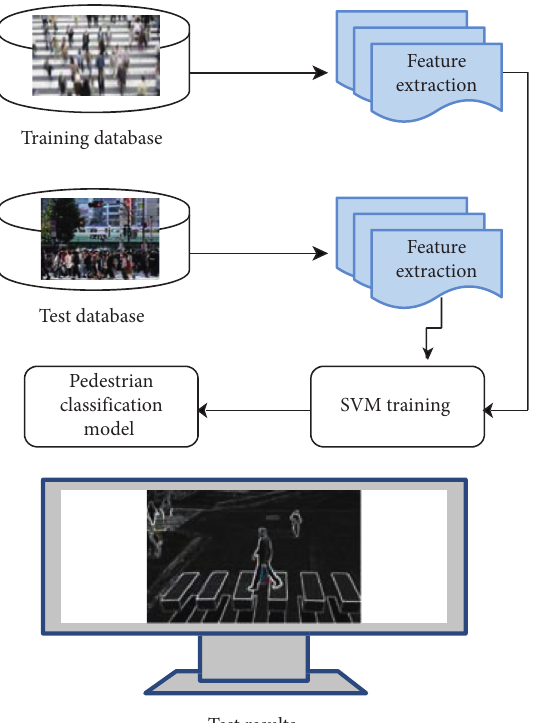
Figure 10: Pedestrian detection process.